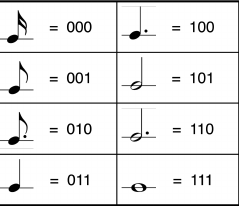
Figure 20. One-dimensional PQCA codes for note